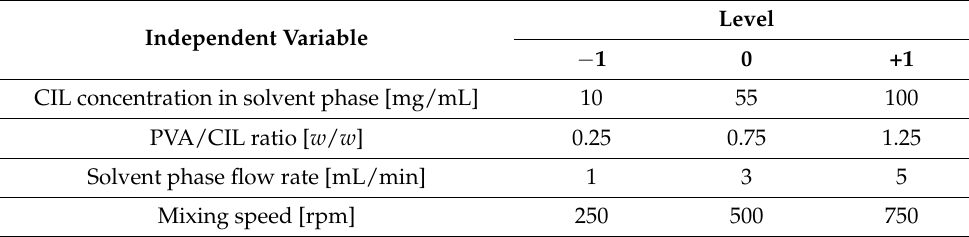
Table 5. Independent variables and their levels used in Central Composite Design studies for LASP characterization and